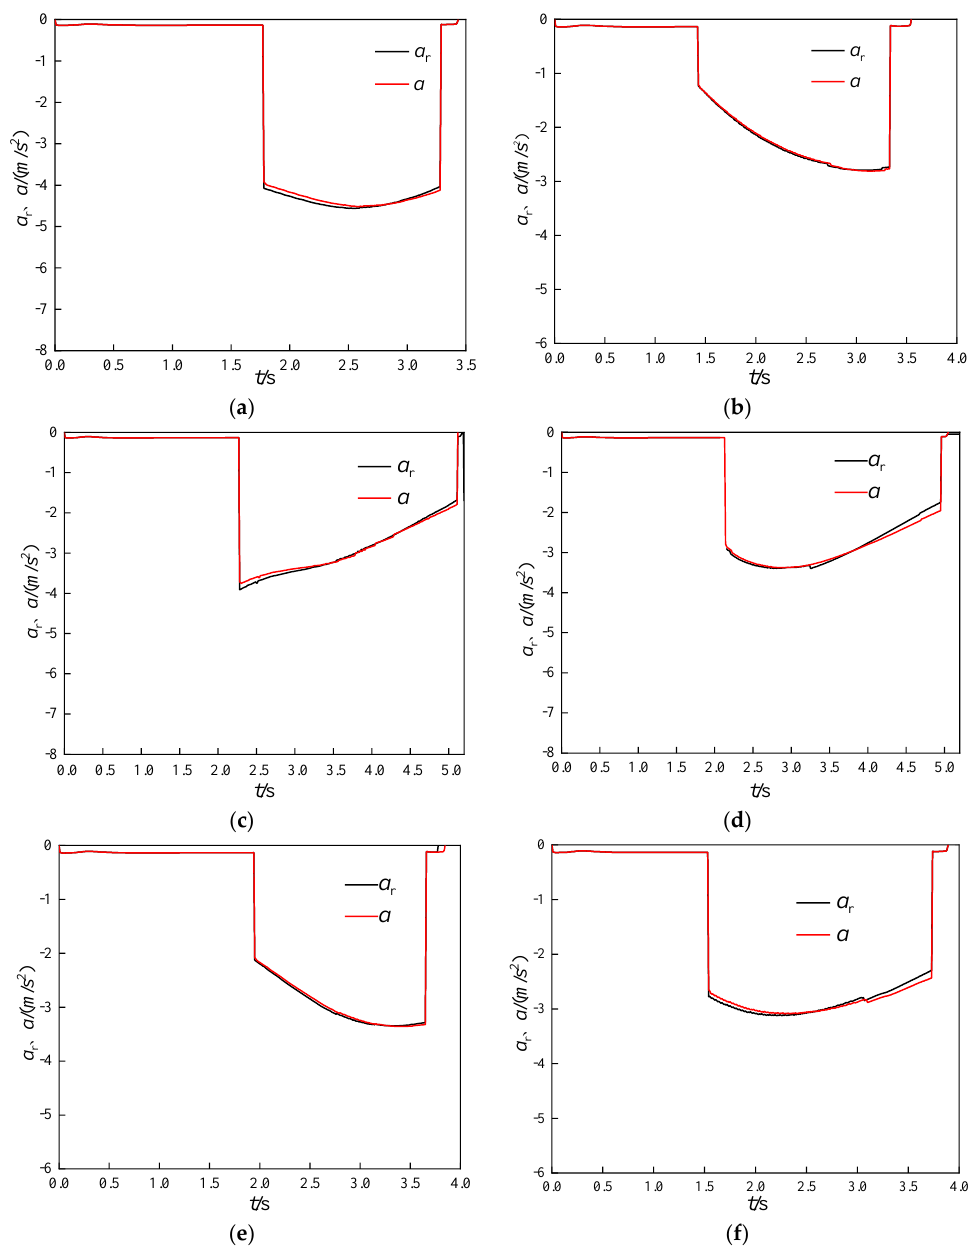
Figure 9. The changes in a r and a in: ( a ) scenario 1, ( b ) scenario 2, ( c ) scenario 3, ( d ) scenario 4, ( e ) scenario 5, and ( f ) scenario 6. Table 4. Specific upper controller parameters.